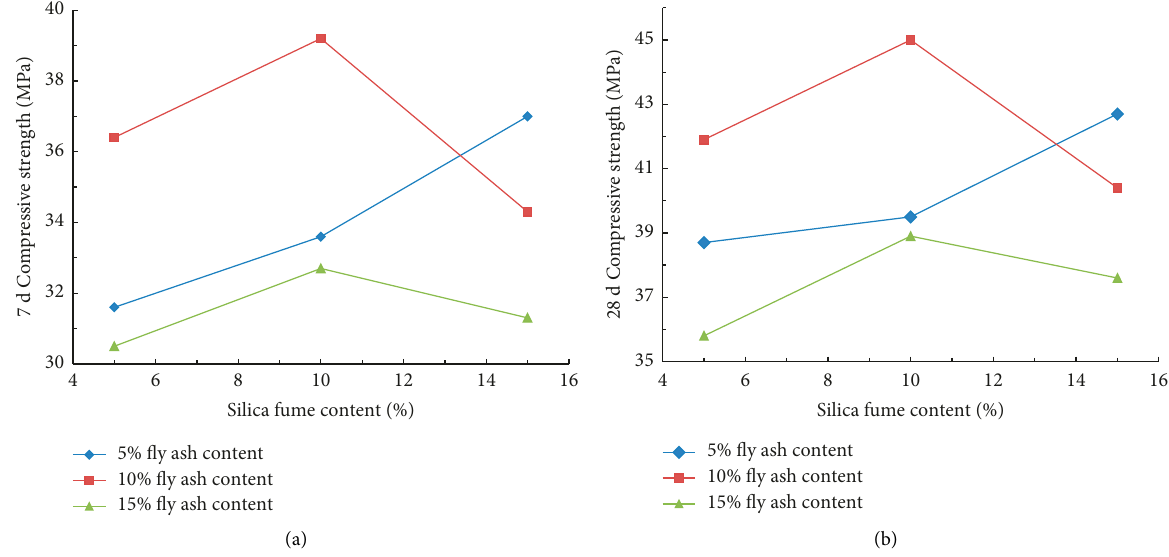
Figure 10: Influence of silica fume content on compressive strength of MPPF coral concrete. (a) The influence of silica fume content on the compressive strength of concrete for 7 d. (b) Influence of silica fume content on 28 d compressive strength of